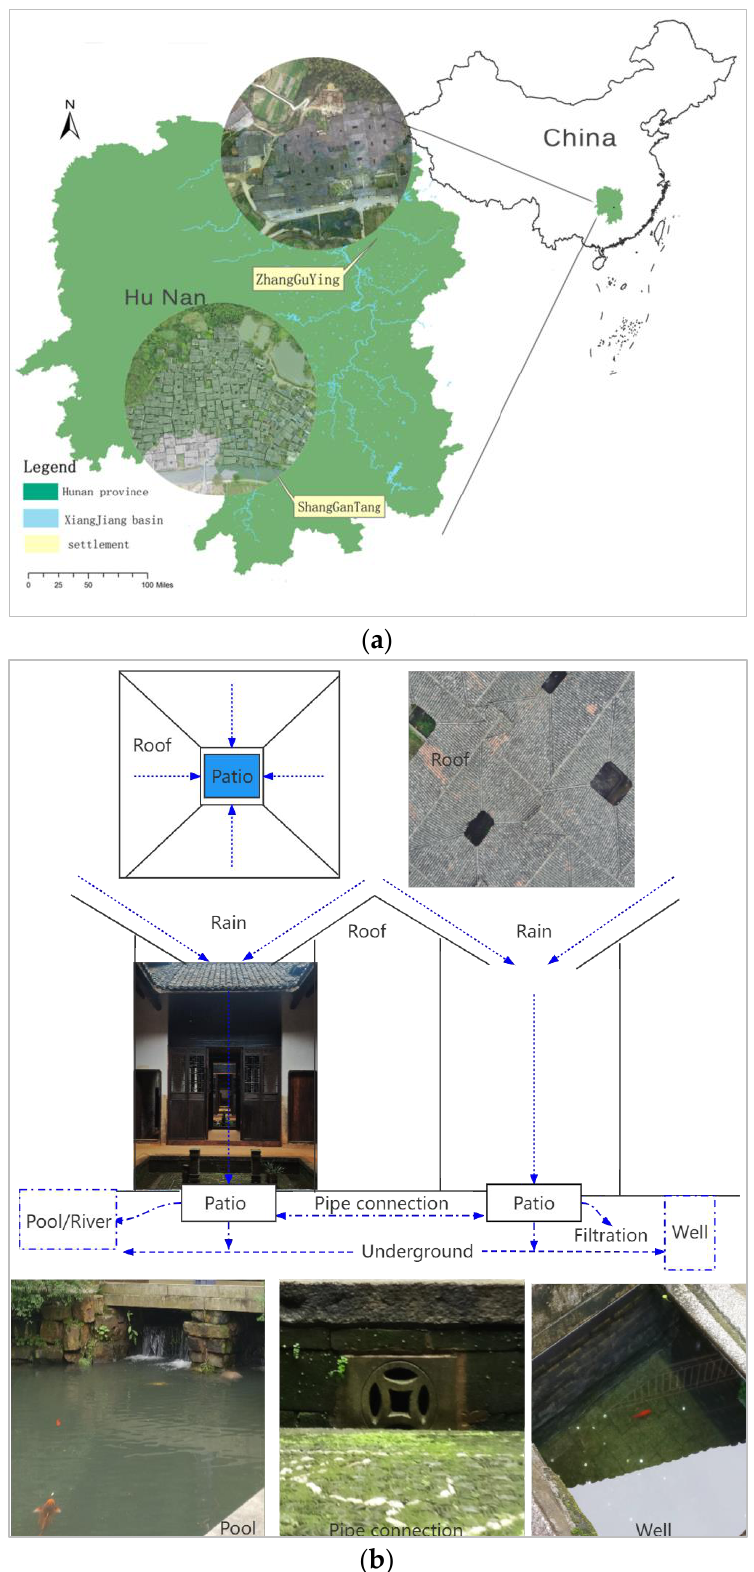
Figure 1. ( a ) Location of the two villages in Xiangjiang River Basin, Southeast China. ( b ) The water collection system used in the villages.